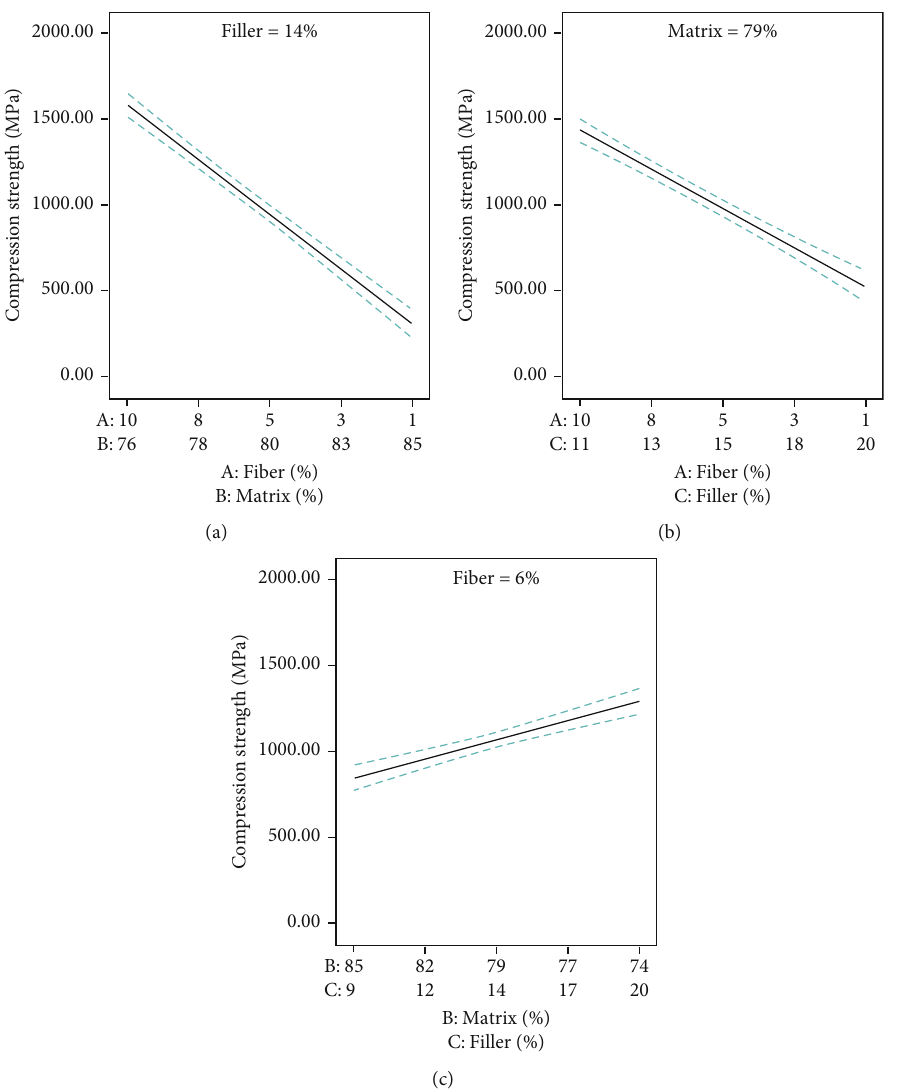
Figure 11: E ff ect of (a) fi ber loading as a function of the matrix, (b) fi ber loading as a function of the fi ller, and (c) matrix loading as a function of fi ller on compressive